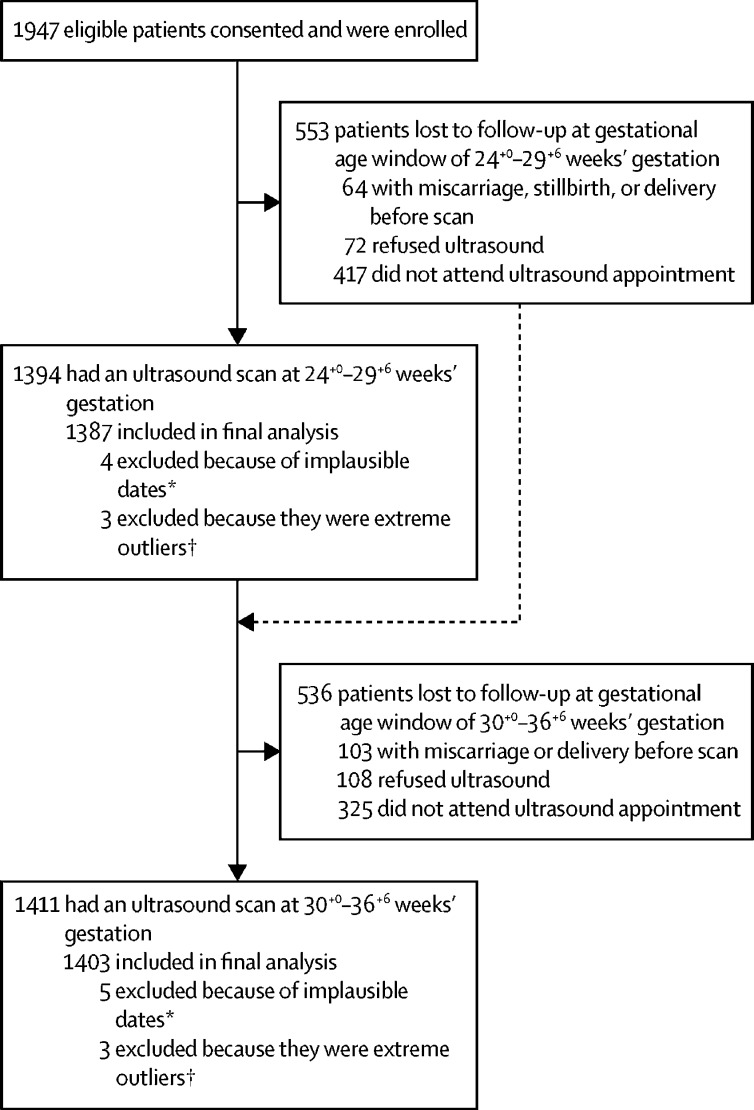
Participant flowchart by ultrasound visit*Exclusion due to implausible dates that could not be reconciled (eg, date of birth before date of ultrasound, or year of ultrasound or birth recorded incorrectly). † Extreme outliers refers to cases in which a difference of greater than 60 days between the gold-standard measurement of gestational age and the gestational age predicted by late pregnancy biometry measurements was observed.